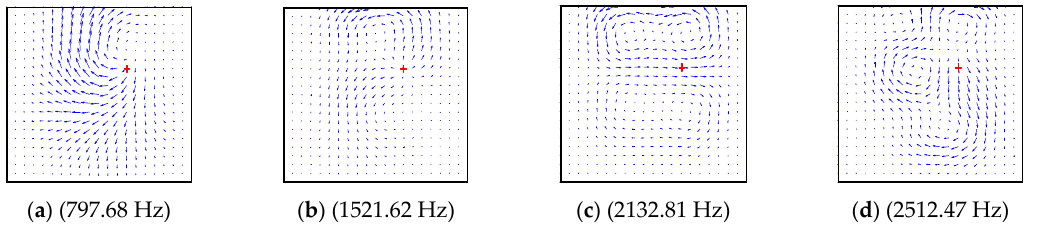
Figure 16. The power flow field for a CSSE laminated plate excited by point force on (0.65 m, 0.65 m). ( a ) (797.68Hz), ( b ) (1521.62 Hz), ( c ) (2132.81 Hz), ( d ) (2512.47 Hz).